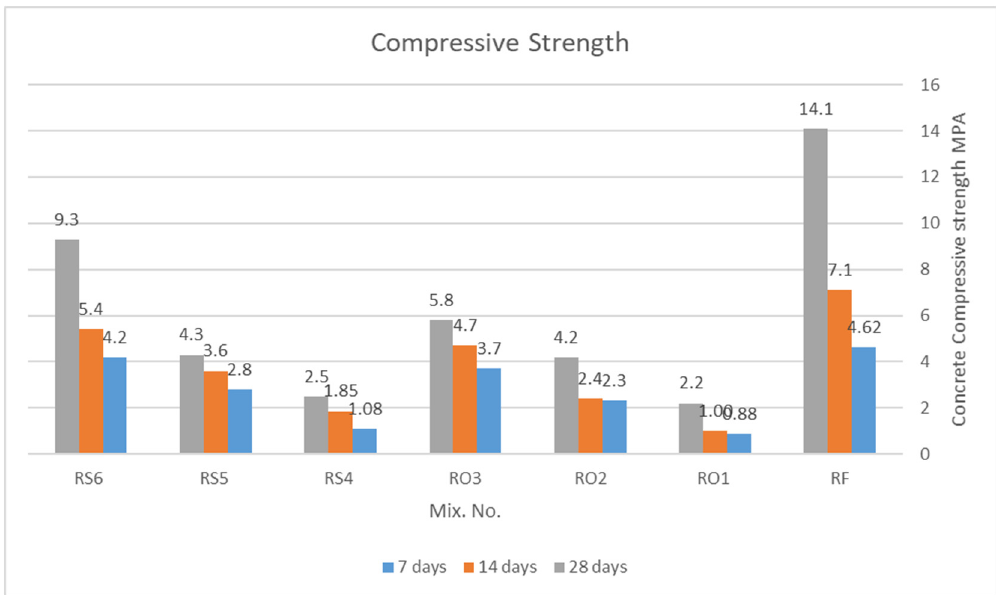
Figure 7. Compressive strength of different samples.